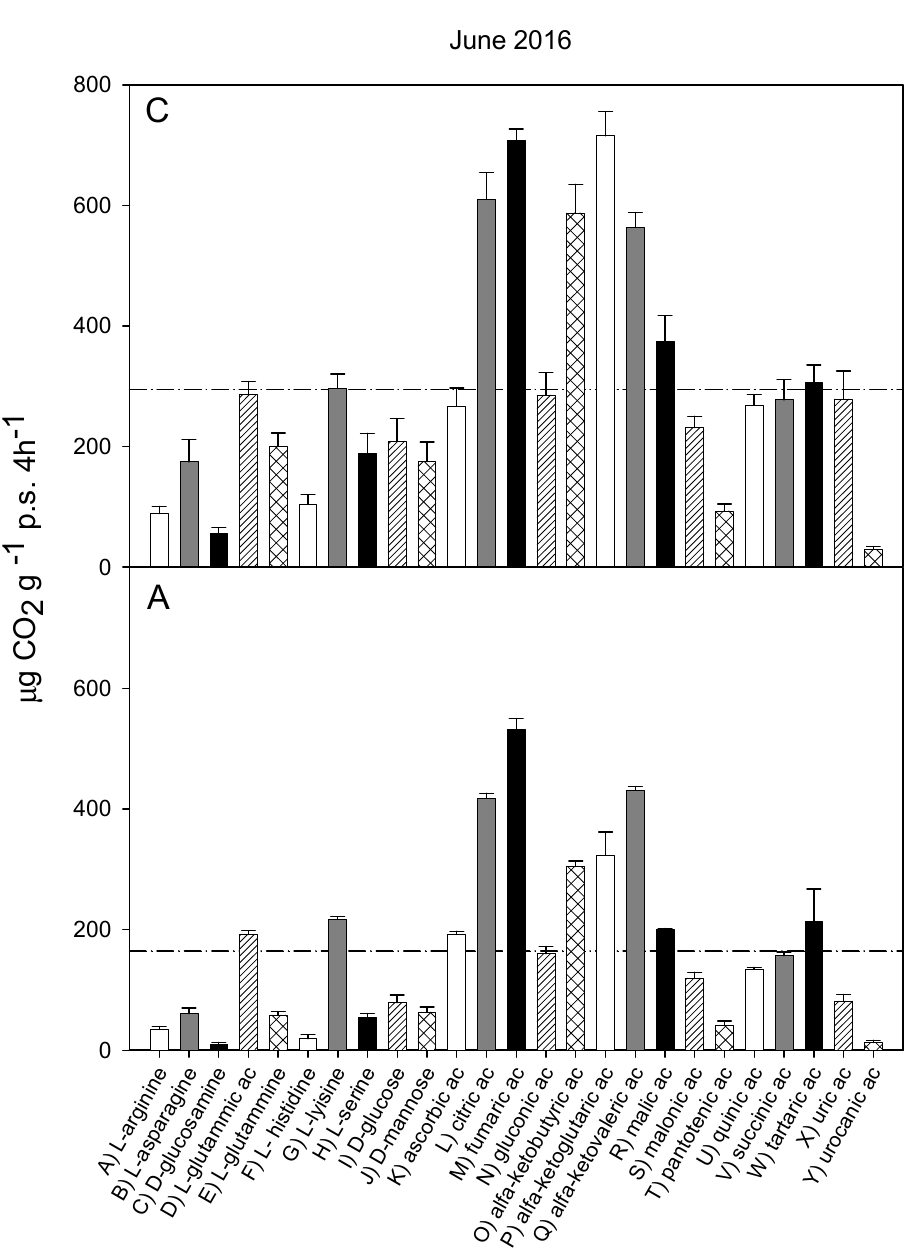
Figure 5. Catabolic response profile of chestnut ( C ) and agricultural ( A ) soils in June 2016. The dotted line represents the average substrate-induced respiration (ASIR), corresponding to 152.8 ± 17.9 in chestnut and to 93.99 ± 19.3 in agricultural soil (the values were significantly different with p < 0.05).